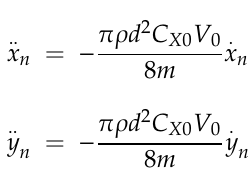
Figure 4 . (a) Lateral thruster angular orientation; (b) impact point errors in the horizontal plane.